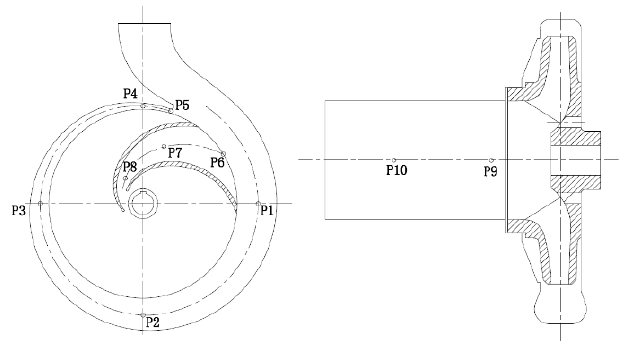
Figure 13. Location of pressure monitoring points.